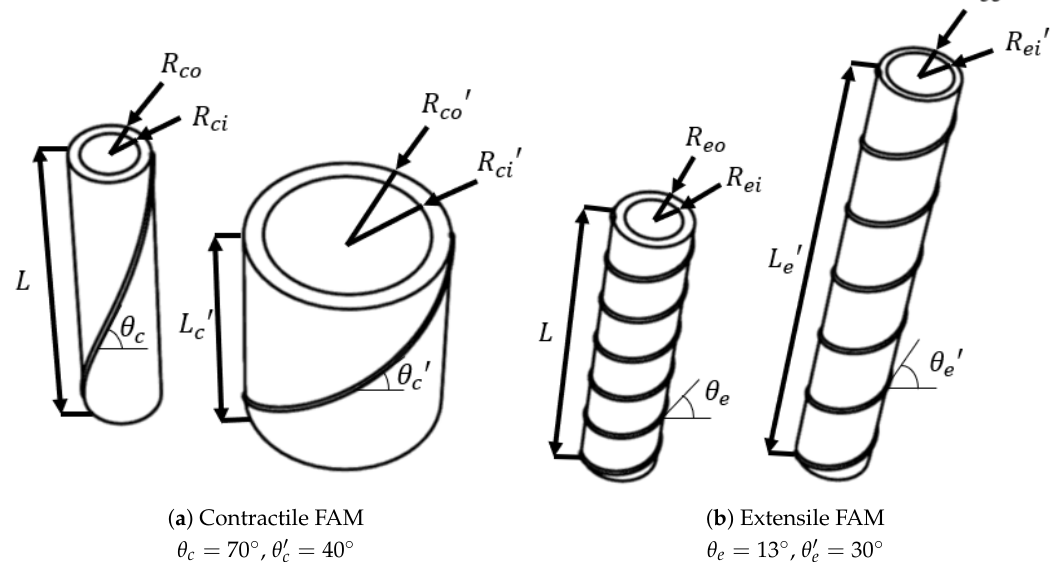
Figure 2. The figure shows contractile and extensile FAMs in the undeformed and deformed states. Here, FAMs are idealized as tubes of variable length and diameter with a geometric constraint imposed by an elliptical thread. Different braid angles of the thread result in two directions of motion. ( a ) For braid angle θ c > 35.26 ◦ , the inner R ci and outer R co radii increase with pressure and the FAM length decreases together with the braid angle θ c . Due to the length decrease, the FAM is classified as contractile. ( b ) For θ e < 35.26 ◦ , the radii decrease with added pressure, and the FAM length increases along with the braid angle θ e to form an extensile